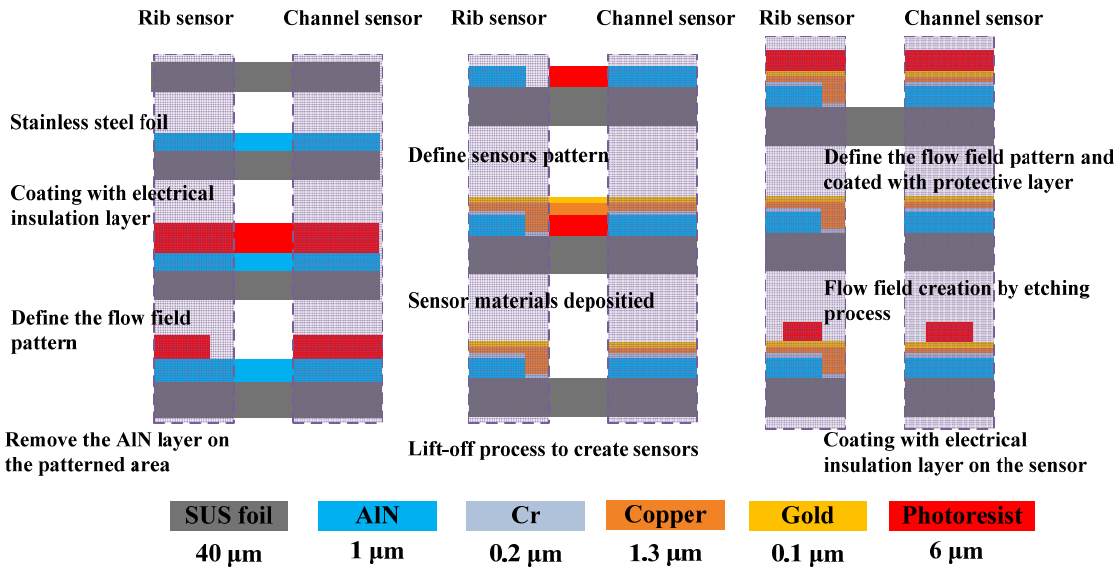
Figure 4. Fabrication of dedicated micro sensors.